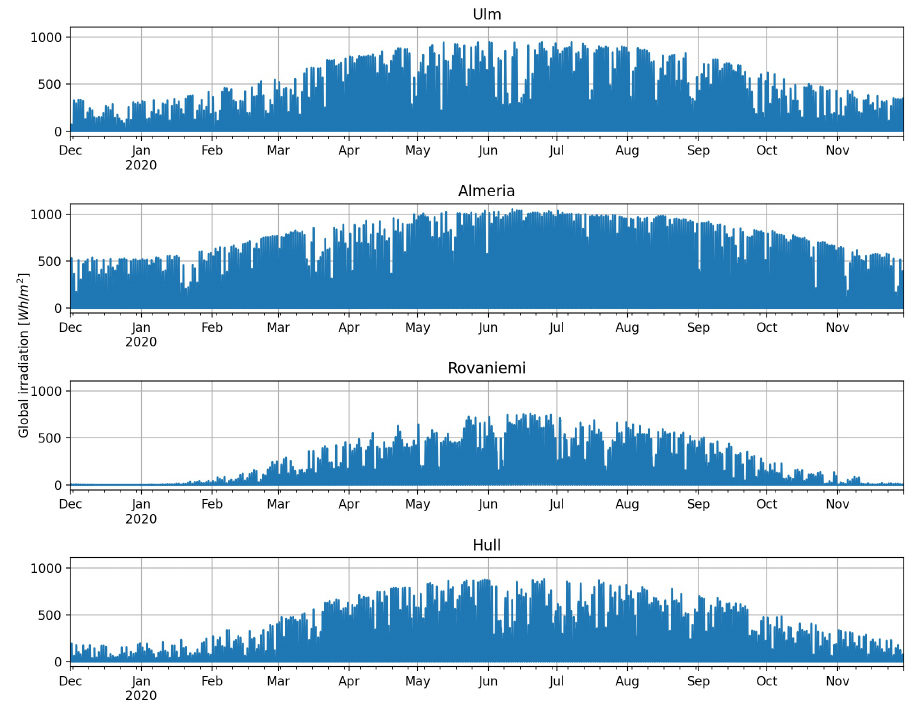
Figure 2. Global irradiation from 1 December 2019 to 30 November 2020.